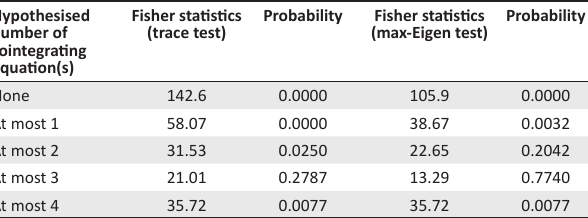
TABLE 4: Fisher cointegration test results.